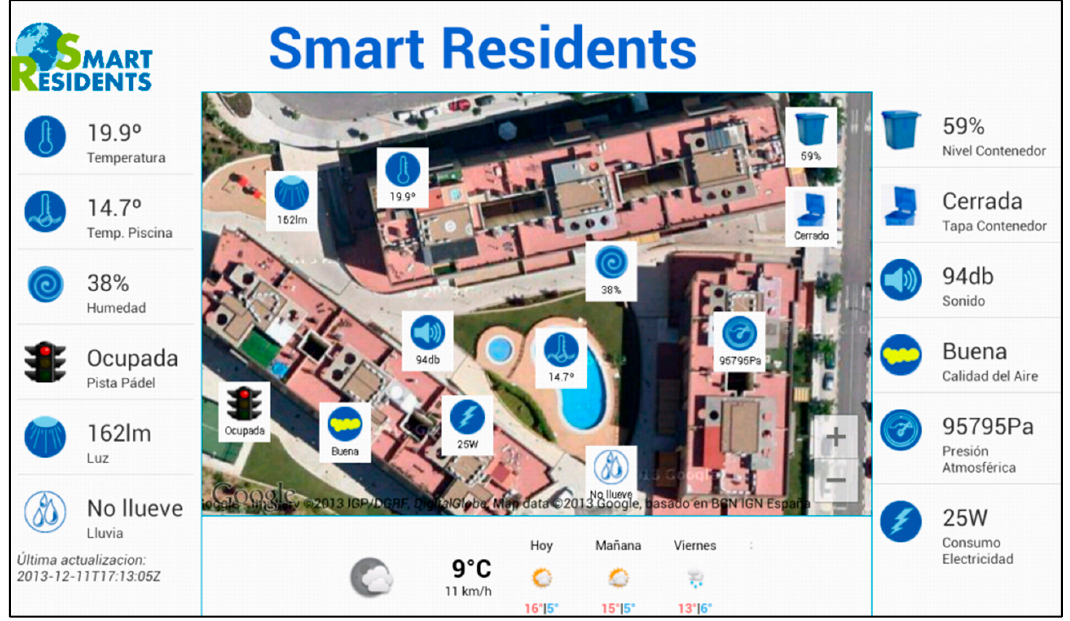
Figure 7. SmartResidents interface.